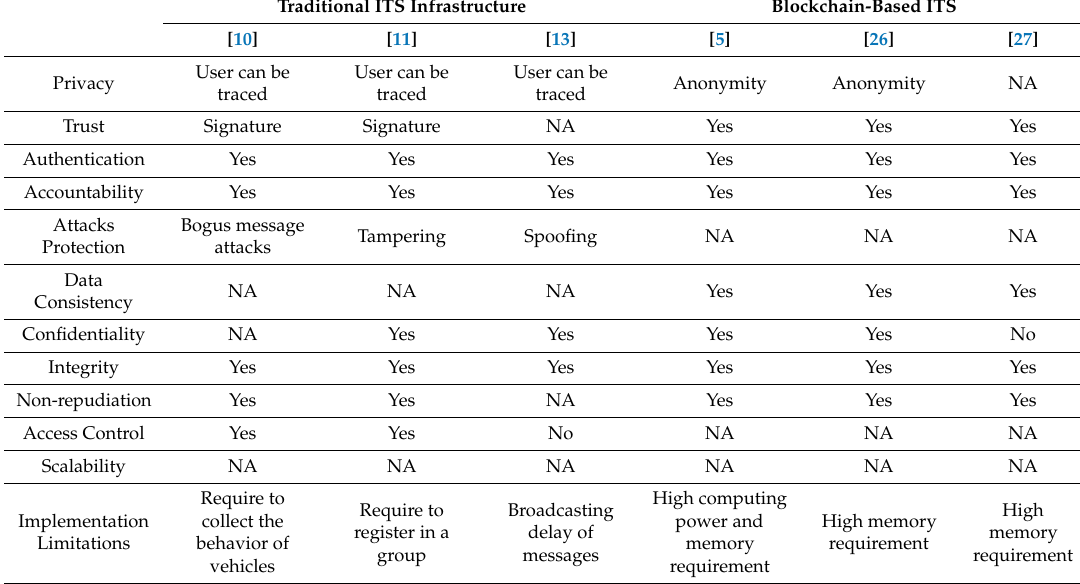
Table 1. Comparisons of the current work on secure